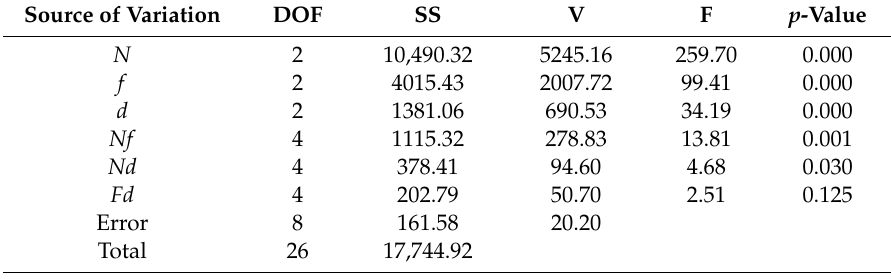
Table 6. ANOVA results for MRR.